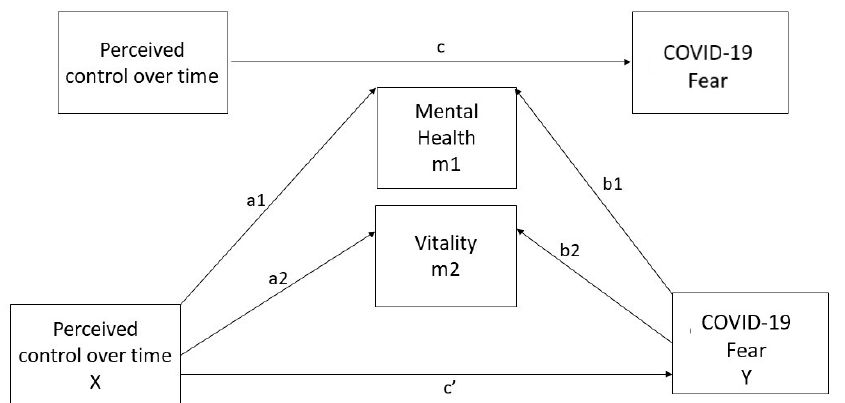
Figure 1. Hypothesized model. Note—perceived control over time: predictor variable; mental health: mediator 1; vitality: mediator 2; COVID-19 fear: outcome variable; a1b1: a specific indirect effect of perceived control over time on COVID-19 fear through mental health; a2b2: a specific indirect impact of perceived control over time on COVID-19 fear through vitality; c’: direct effect of perceived control over time on COVID-19 fear; total indirect effect: a1b1 + a2b2.